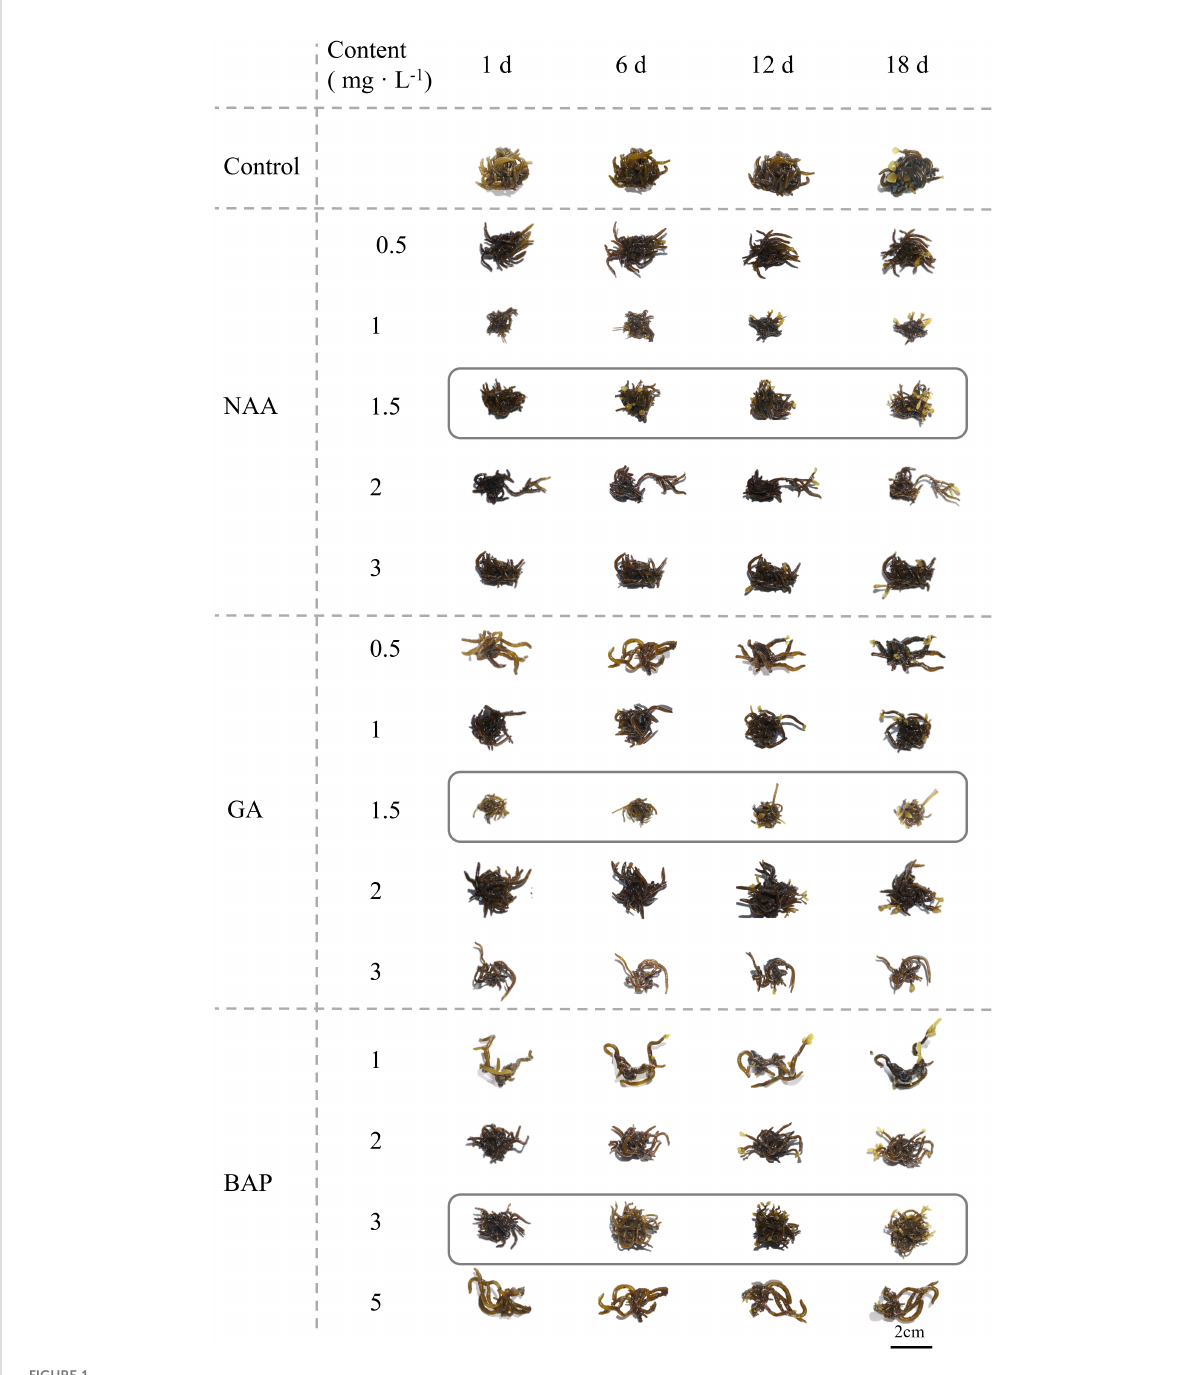
FIGURE 1 Morphological changes in Sargassum fusiforme holdfasts with different concentrations of three exogenous hormones applied for different incubation